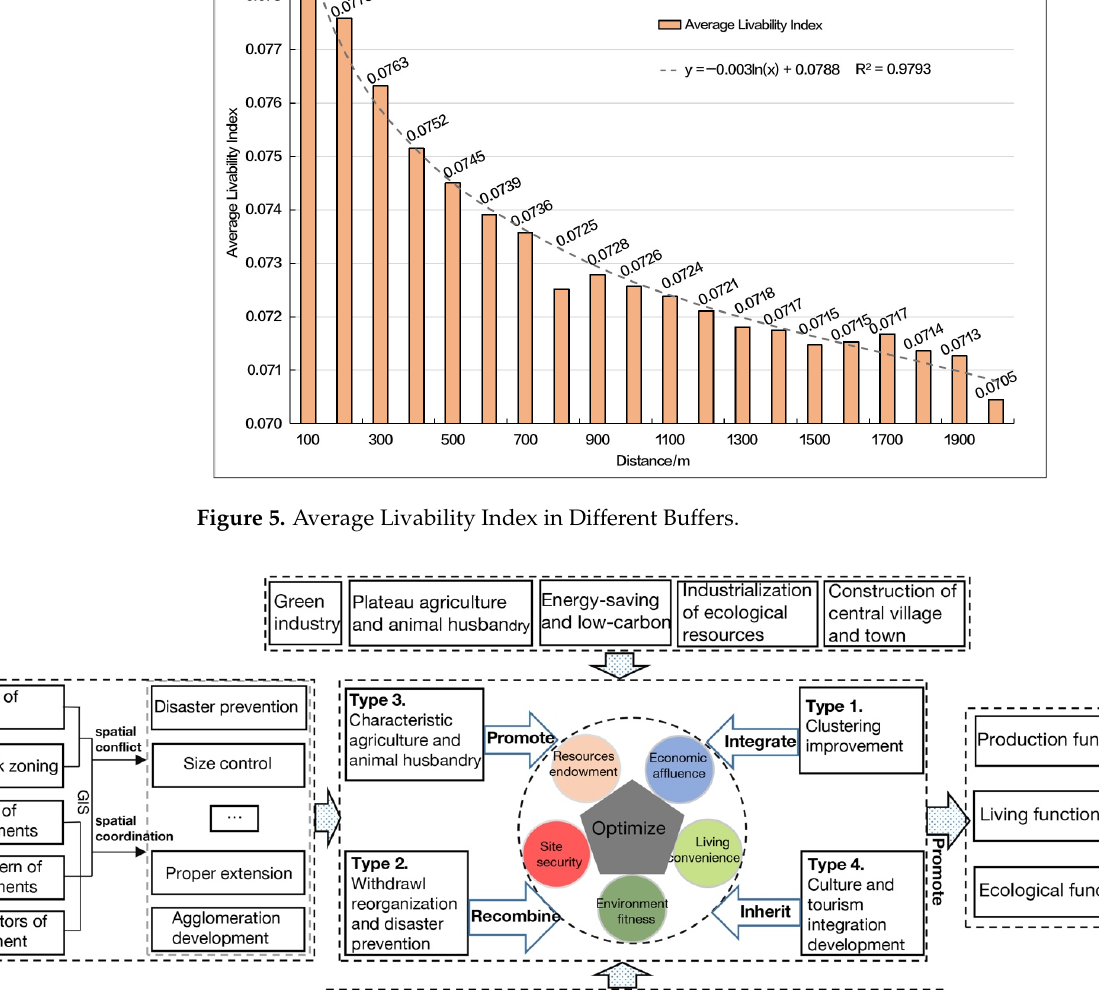
Figure 5. Average Livability Index in Different Buffers.